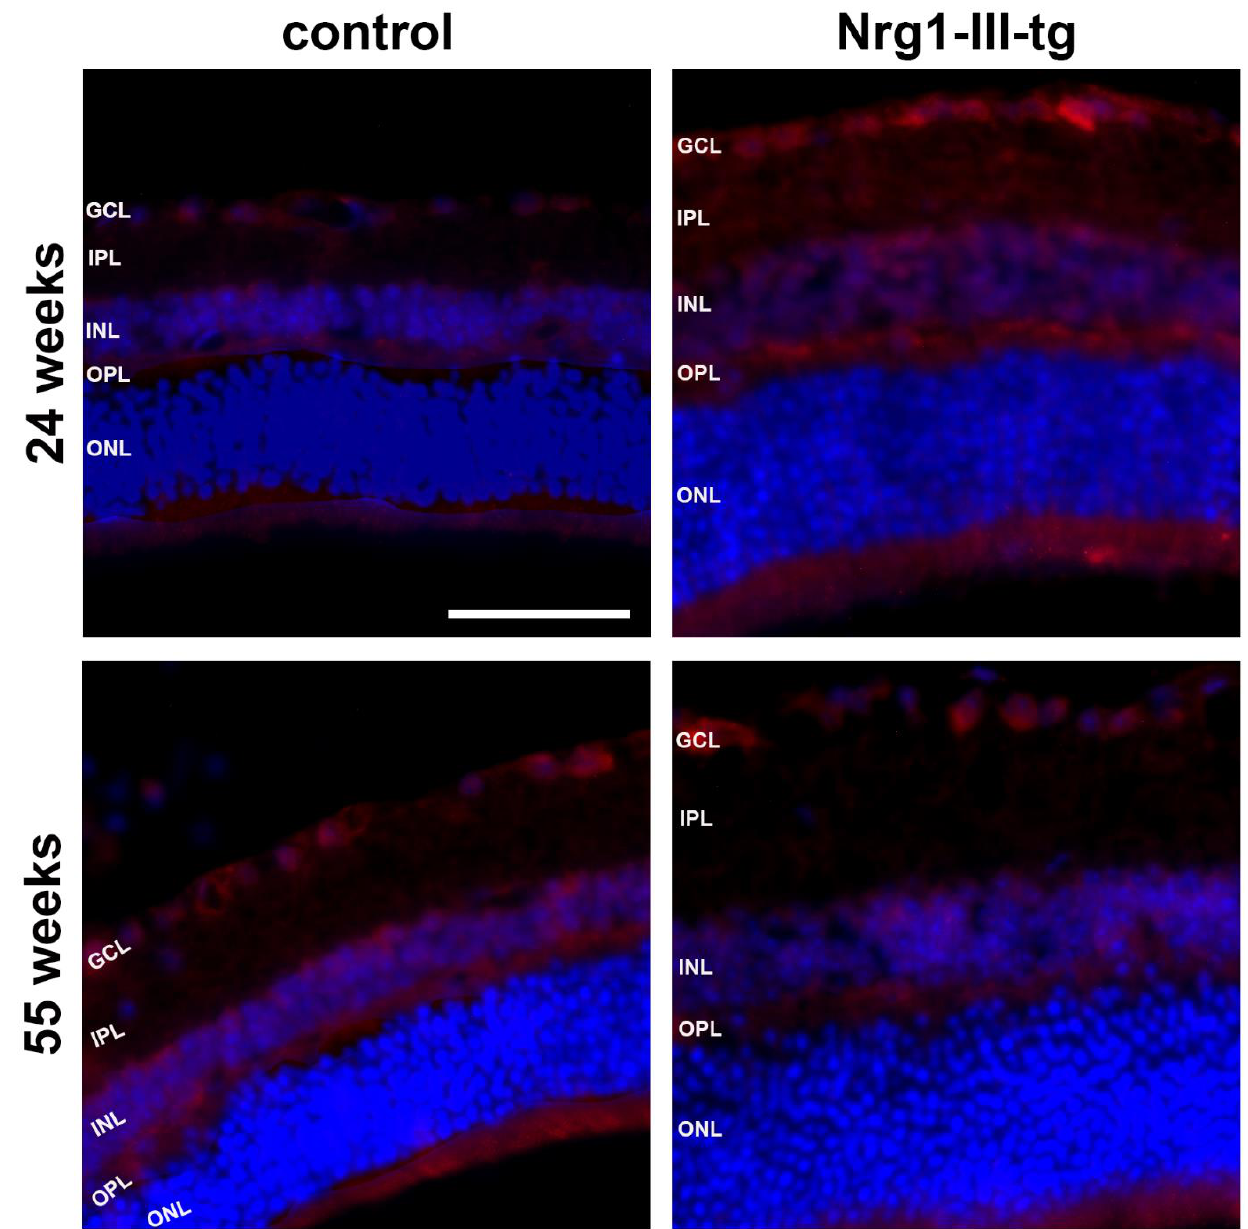
Figure 5. Immunohistochemical staining against neuregulin. The trophic factor neuregulin (red) in frozen sections of the retina of the mouse eye at 24 weeks and 55 weeks of control and Nrg1-III-tg as indicated. The cell nuclei were stained with DAPI (blue); GCL-ganglion cell layer; IPL-inner plexiform layer; INL-inner nuclear layer; OPL-outer plexiform layer; ONL-outer nuclear layer. Scale bar: 50 μ m.